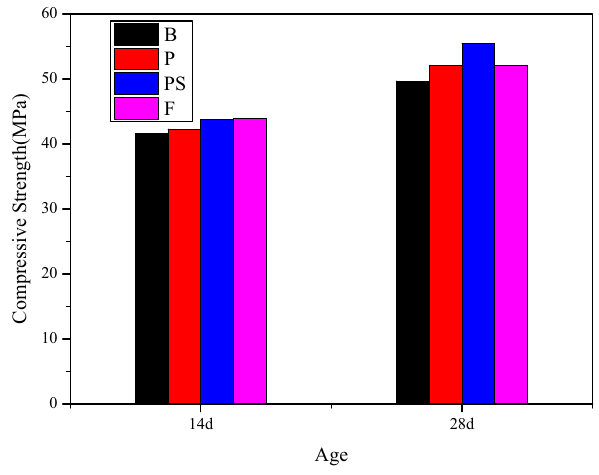
Figure 5: Compressive strength of repair materials.